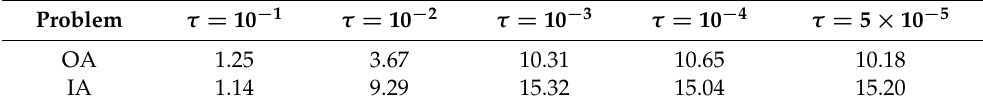
Table 3. Time consumption in hours for the solution of inner and outer problems with decreasing τ .